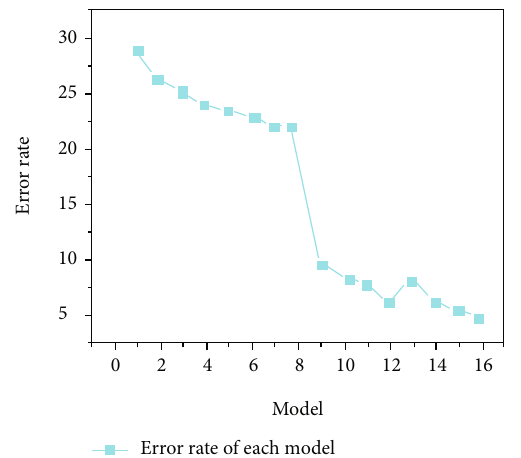
Figure 13: Top-1 error data map (top-1 represents the data corresponding to the maximum probability of the correct